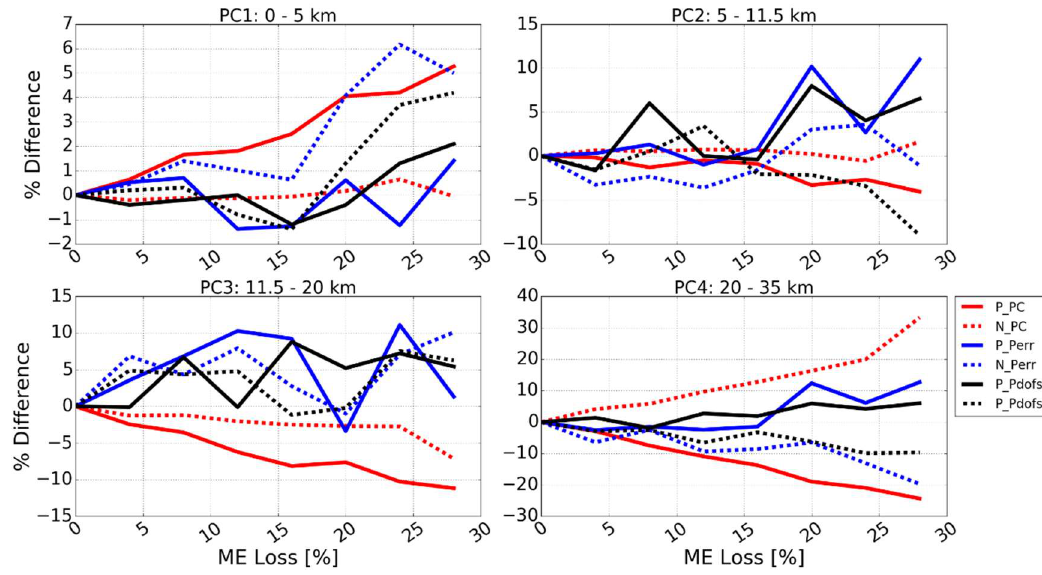
Figure 5. The same as Figure 2 but for N 2 O.